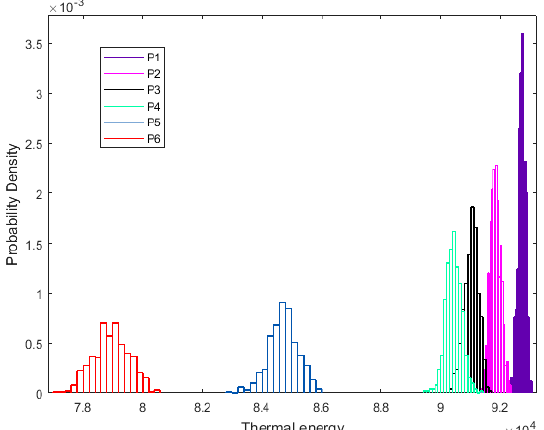
Figure 15. The histogram of probability density distribution of thermal energy in graphene with its heat source in zigzag edges (P1–P6 represents the percentage of vacancy as 0.2%, 0.5%, 0.8%, 1%, 3%, and 5%, respectively, and the unit for thermal energy is J).